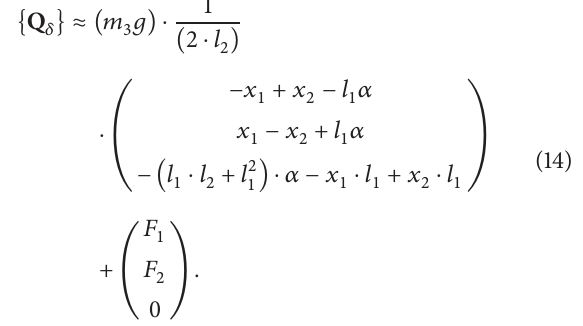
authors in the present research and one of the typical cases is shown in numerical plots in Figures 4 and